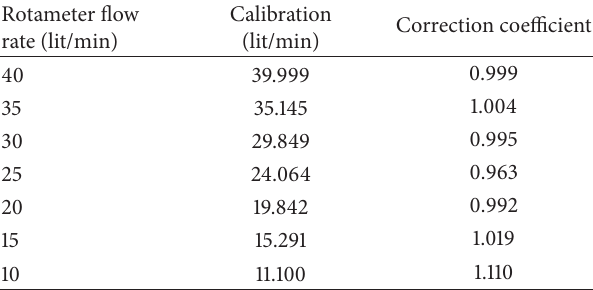
Table 2: Results of calibration test for rotameter.